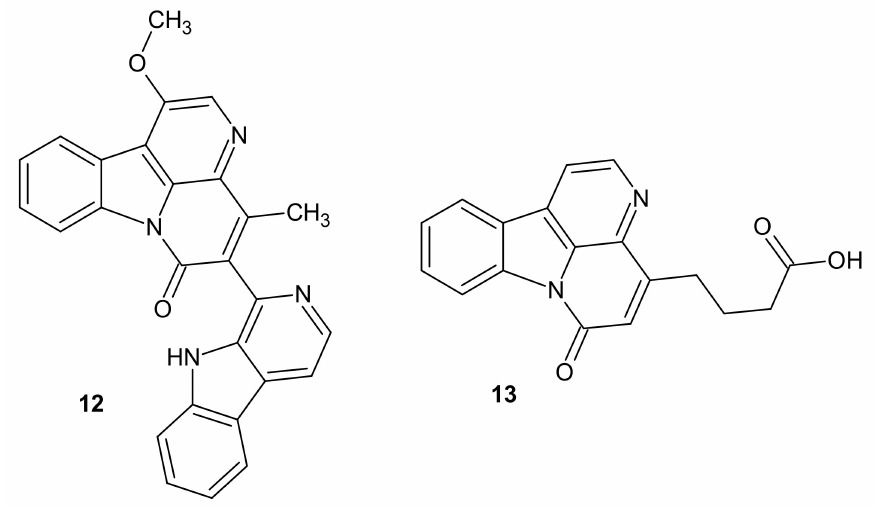
Figure 3. Structures of quassidine E 12 and canthin-16-one-14-butyric acid 13 . Natural products—cimiciduphytine 14 and eburnane derivatives 15 (Figure 4)—were evaluated as natural painkillers and antihypertensive agents, which could be used in cerebral circulation disturbance therapy [16].